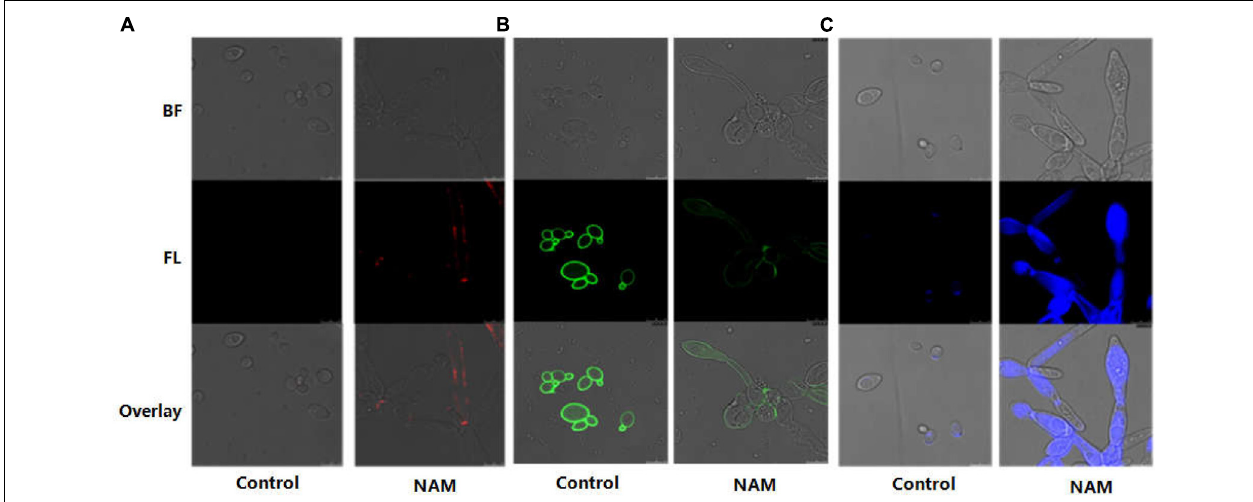
FIGURE 4 | Effect of NAM on cell wall organization. C. albicans cells were treated with 20 mM of NAM for 16 h and then stained with β -glucan antibody to detect β -(1,3)-glucan (A) Concanavalin-A to detect mannan (B) and calcofluor white to detect chitin (C) . Bright field (BF), fluorescence (FL), and overlay were shown individually.